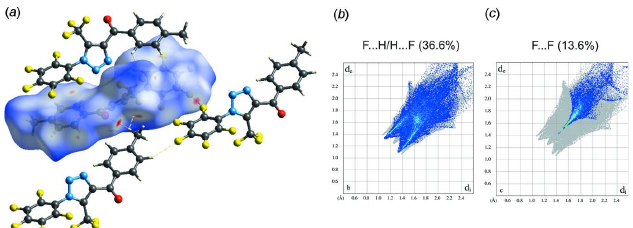
Figure 4 ( a ) Hirshfeld surface for (I) mapped with d norm over the range (cid:4) 0.12 to 1.53 a.u. showing C—H (cid:3)(cid:3)(cid:3) O and C—H (cid:3)(cid:3)(cid:3) F hydrogen-bonded contacts as well as F (cid:3)(cid:3)(cid:3) F contacts. Fingerprint plots resolved into ( b ) F (cid:3)(cid:3)(cid:3) H/H (cid:3)(cid:3)(cid:3) F and ( c ) F (cid:3)(cid:3)(cid:3) F contacts. Neighbouring molecules associated with close contacts are also